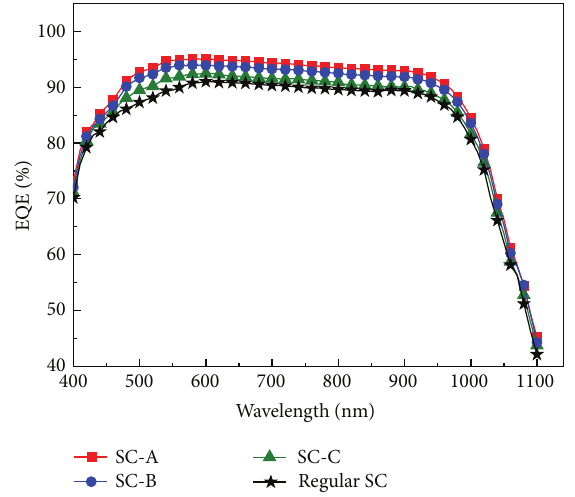
Figure5:MeasuredEQEasafunctionofwavelength 𝜆 forfourtypes of SC with different surface roughness.